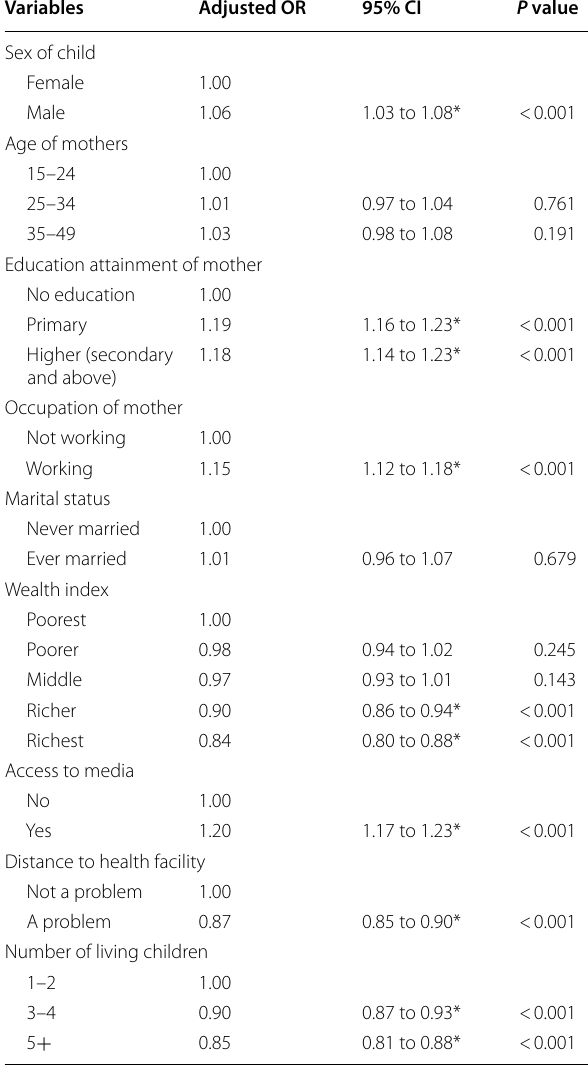
Table 3 Multivariable associations between socio-demographic factors and health treatment seeking behaviour for childhood